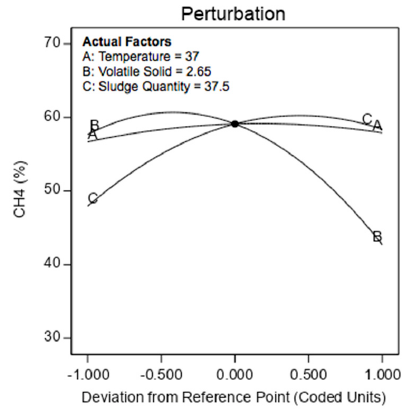
Figure 9. Perturbation plot showing the effect of all factors on CH 4 %.